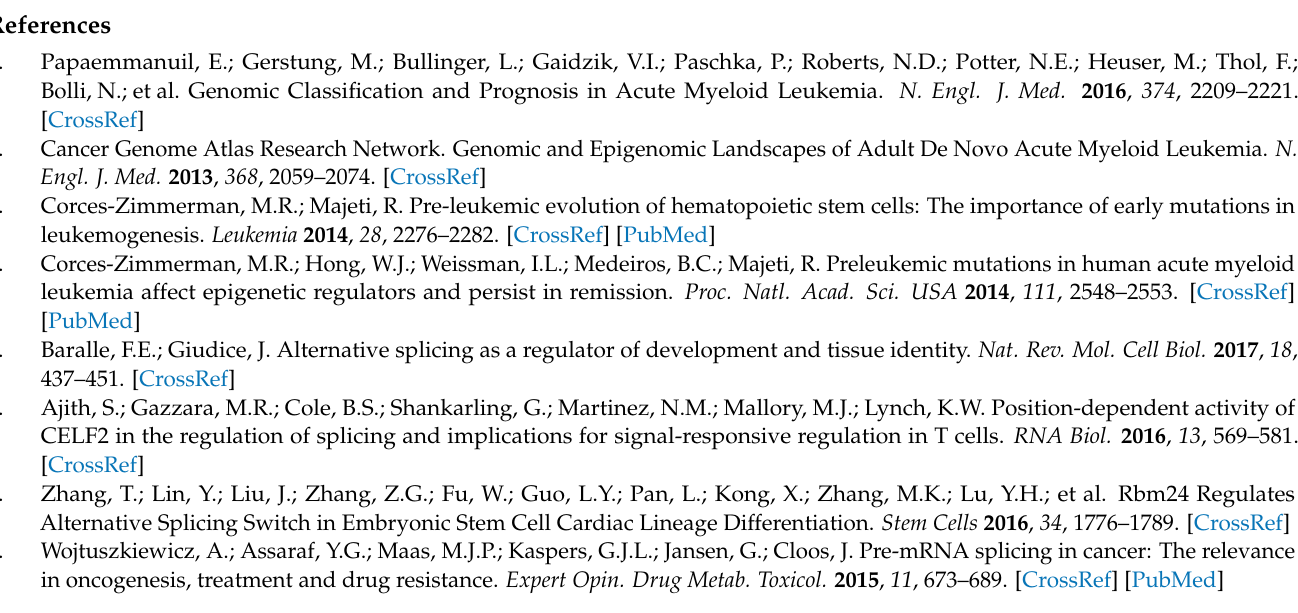
Table S2. Metadata for DNMT3A, FLT3 -ITD and NPM1 mutation in the validation cohort, Table